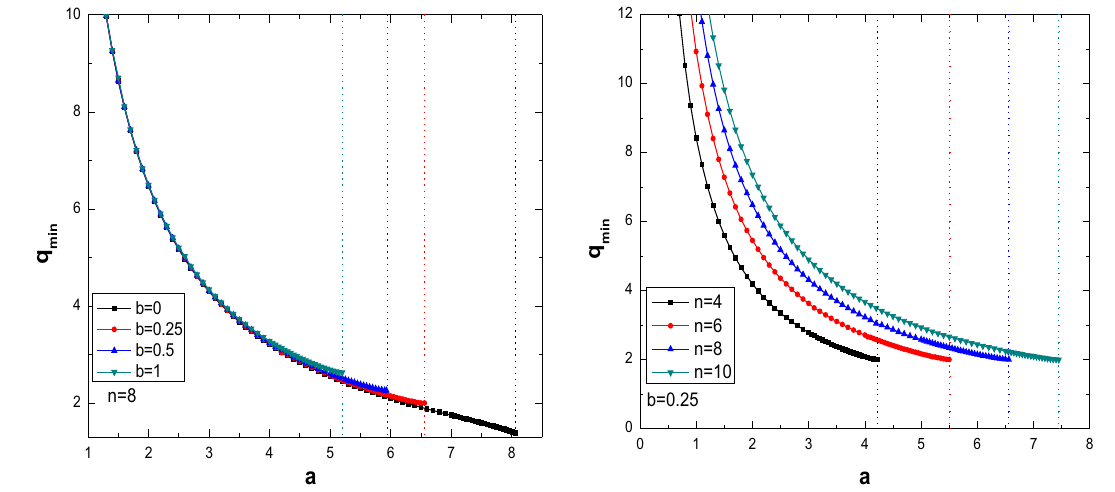
Fig. 2 The minimal charge q min as a function of the amplitude a . Left: For the fixed n = 8, the curves from top to bottom correspond to b = 1 , 0 . 5 , 0 . 25 , 0, respectively. Right: For the fixed b = 0 . 25, the curves from top to bottom correspond to n = 10 , 8 , 6 , 4, respectively